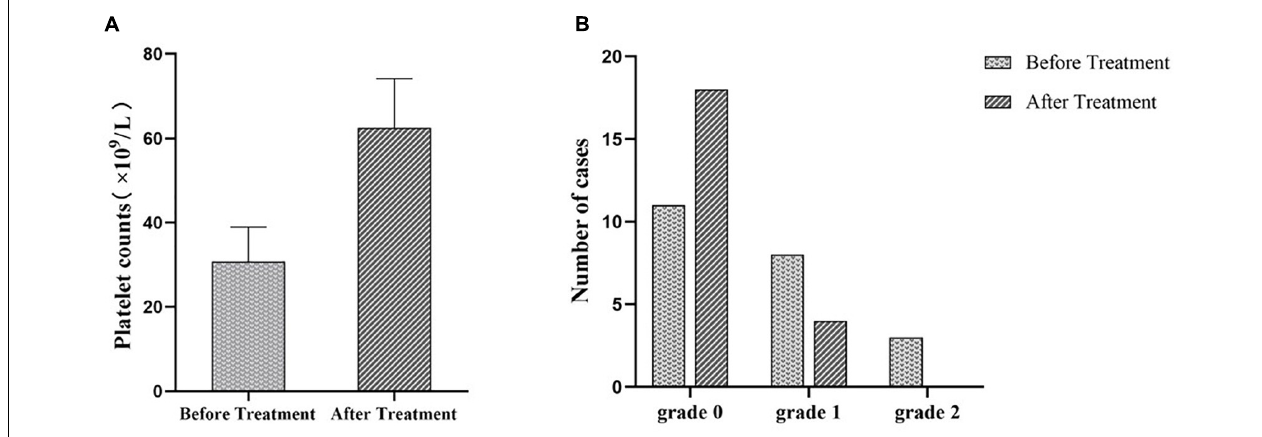
FIGURE 12 | PLT counts and bleeding in patients with ITP after treatment with EJSW. (A) The platelet counts of ITP patients before and after treatment. (B) The number of cases of ITP patients with bleeding. Grade 0 = no bleeding; Grade 1 = petechiae; Grade 2 = mild blood loss.